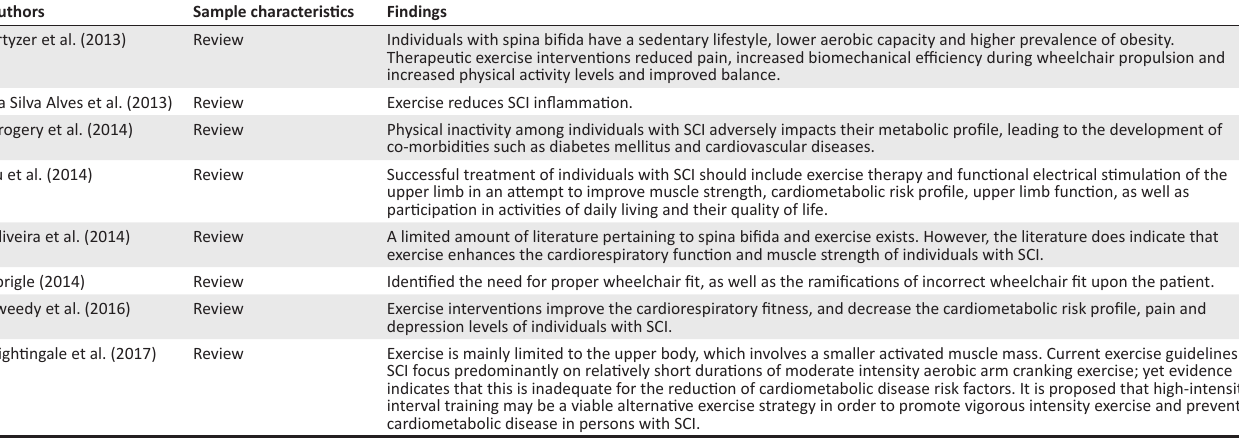
TABLE 4: Review papers of wheelchair users with spinal cord injuries (2013–2017) ( n =